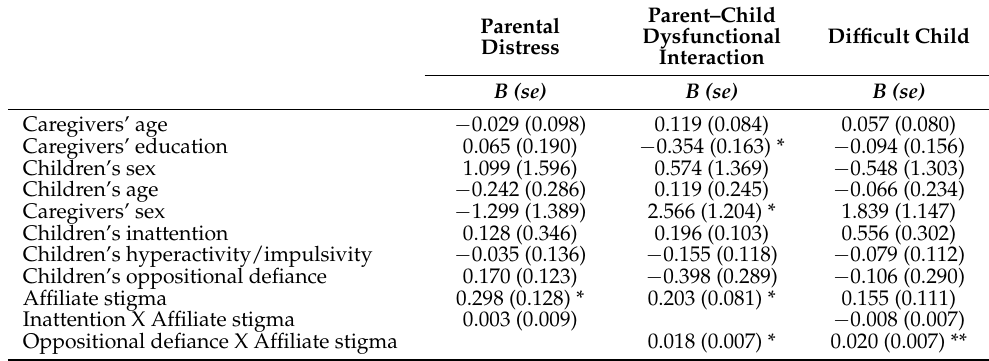
Table 3. Moderating Effects of Children’s Inattention and Oppositional Defiance on the Association between Affiliate Stigma and Parenting Stress: Multivariate Linear